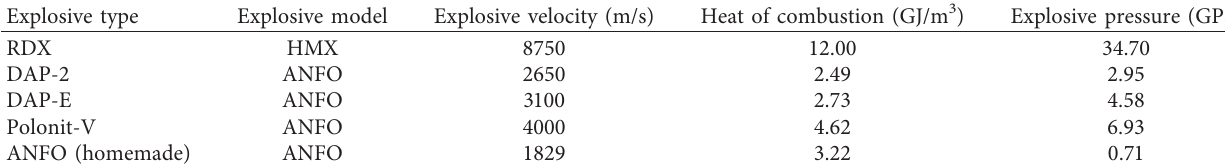
Table 2: Explosive material definition in the numerical model.